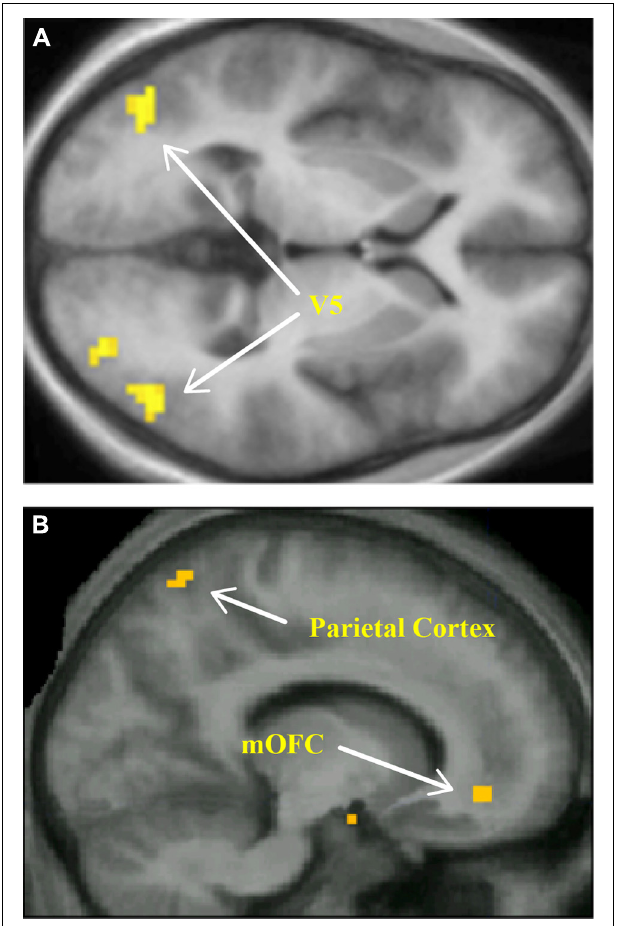
FIGURE 4 |Among the brain areas where the intensity of activity is proportional to the preferred pattern of kinetic stimuli are areasV5, seen here in a horizontal brain section (A) and the parietal cortex, shown in a sagittal section (B). The activity inV5 that correlated with the preferred ratings of these kinetic patterns also correlated with activity in the mOFC (B) . From Zeki and Stutters